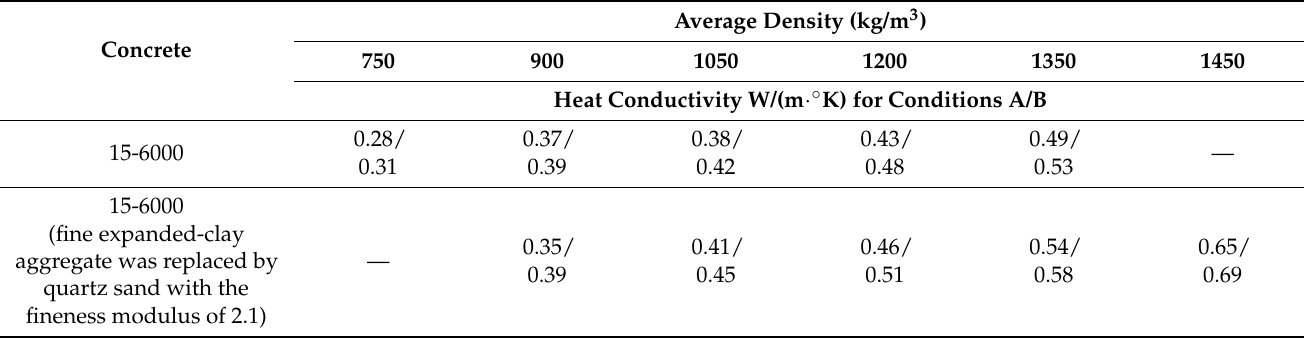
Table 10. Heat conductivity of lightweight